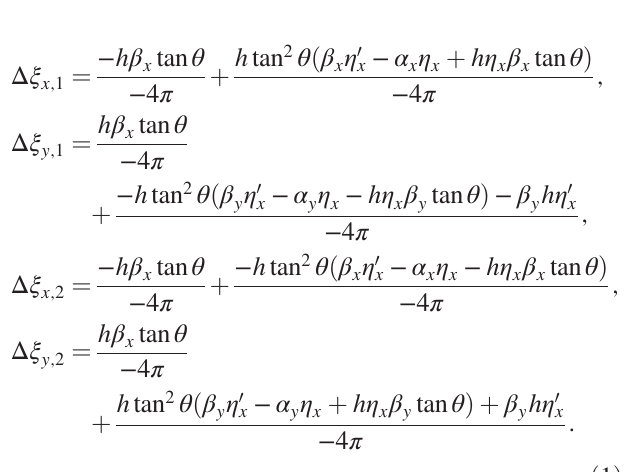
FIG. 1. Layout of